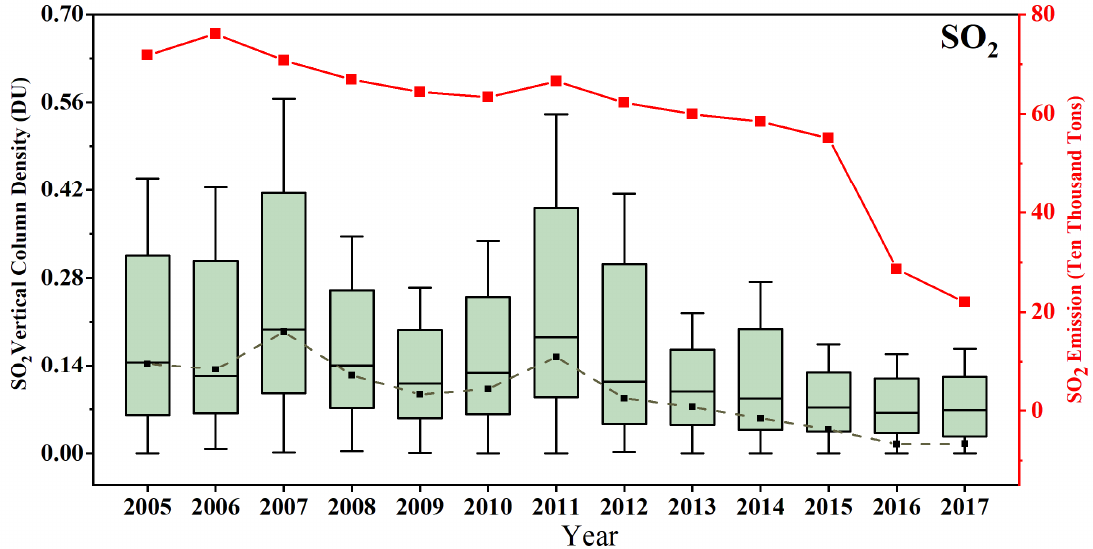
Figure 4. Box plots of annual OMI SO 2 VCD and statistical SO 2 emissions (red) over Hubei province during 2005–2017. In each box, the black line in the center is the median and the lower and upper limits are the first and the third quartiles, respectively. The lines extending vertically from the box indicate the maximum and minimum values. The black squares indicate the annual means of OMI SO 2 .